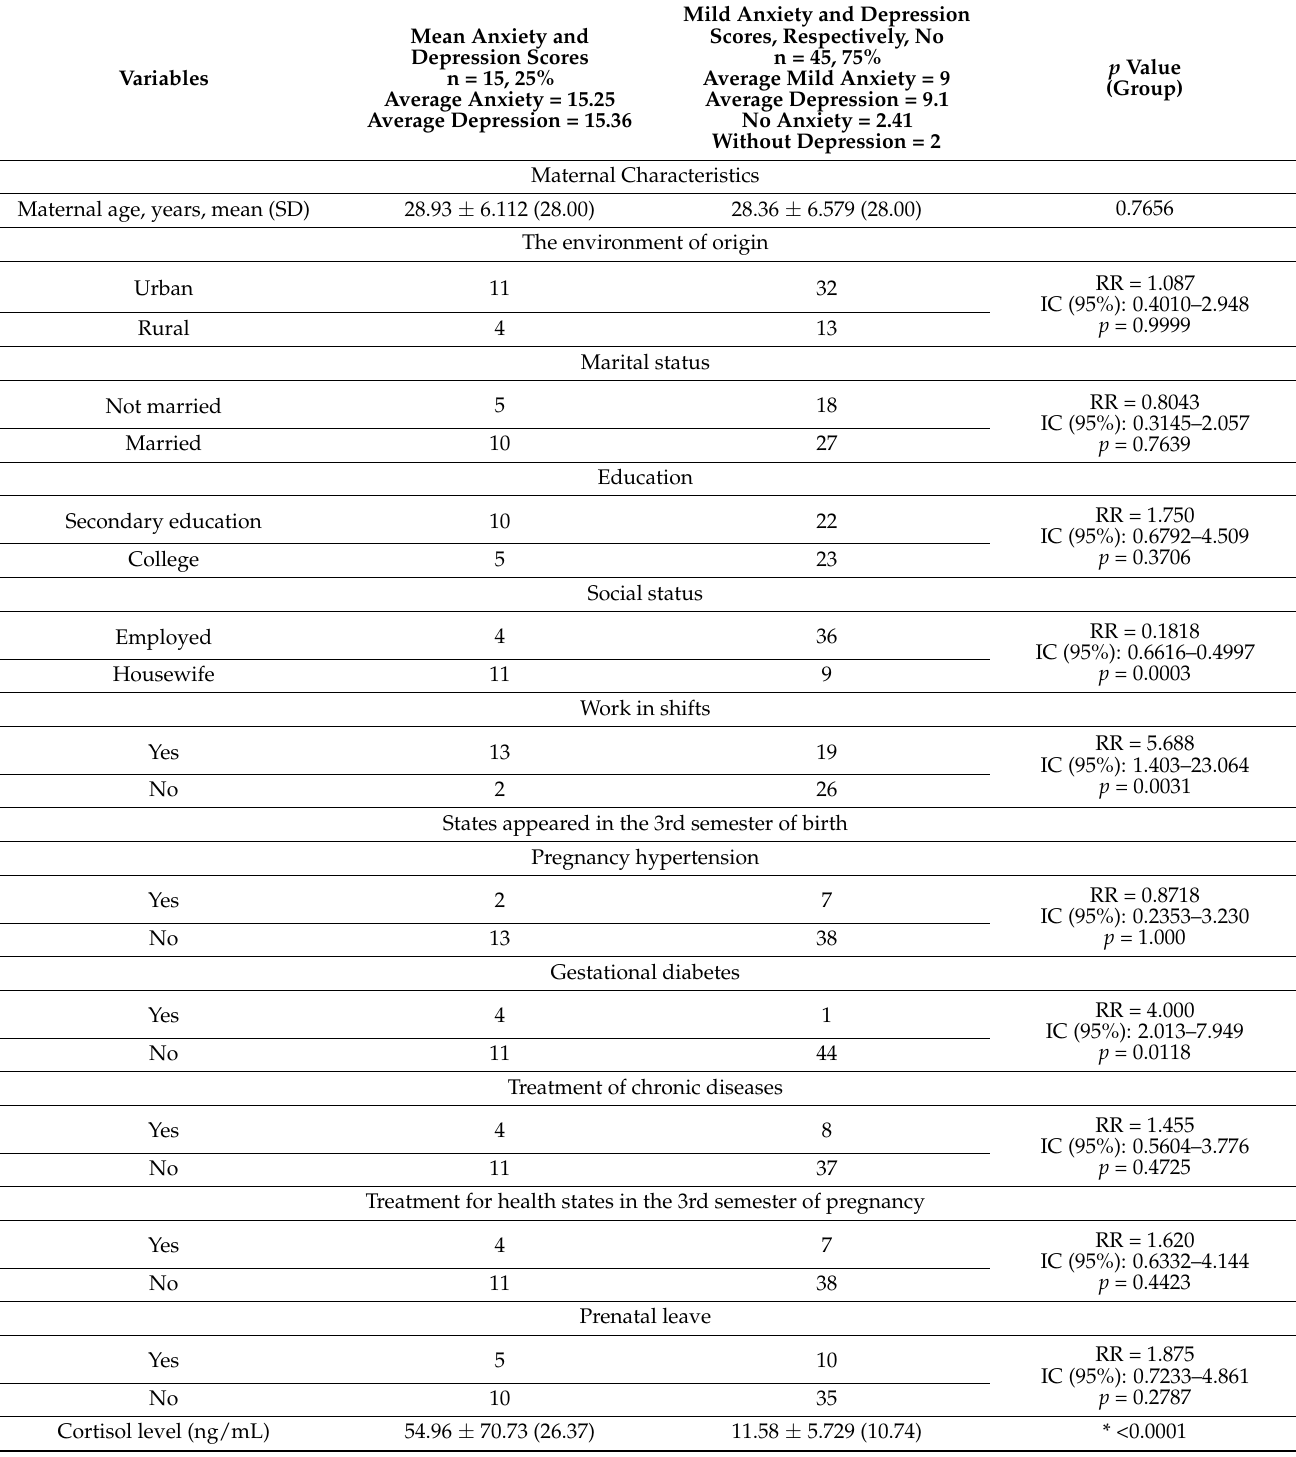
Table 3. Demographics, obstetrical characteristics, Salivary Cortisol level, HADS * score. Mean Anxiety and Depression Variables